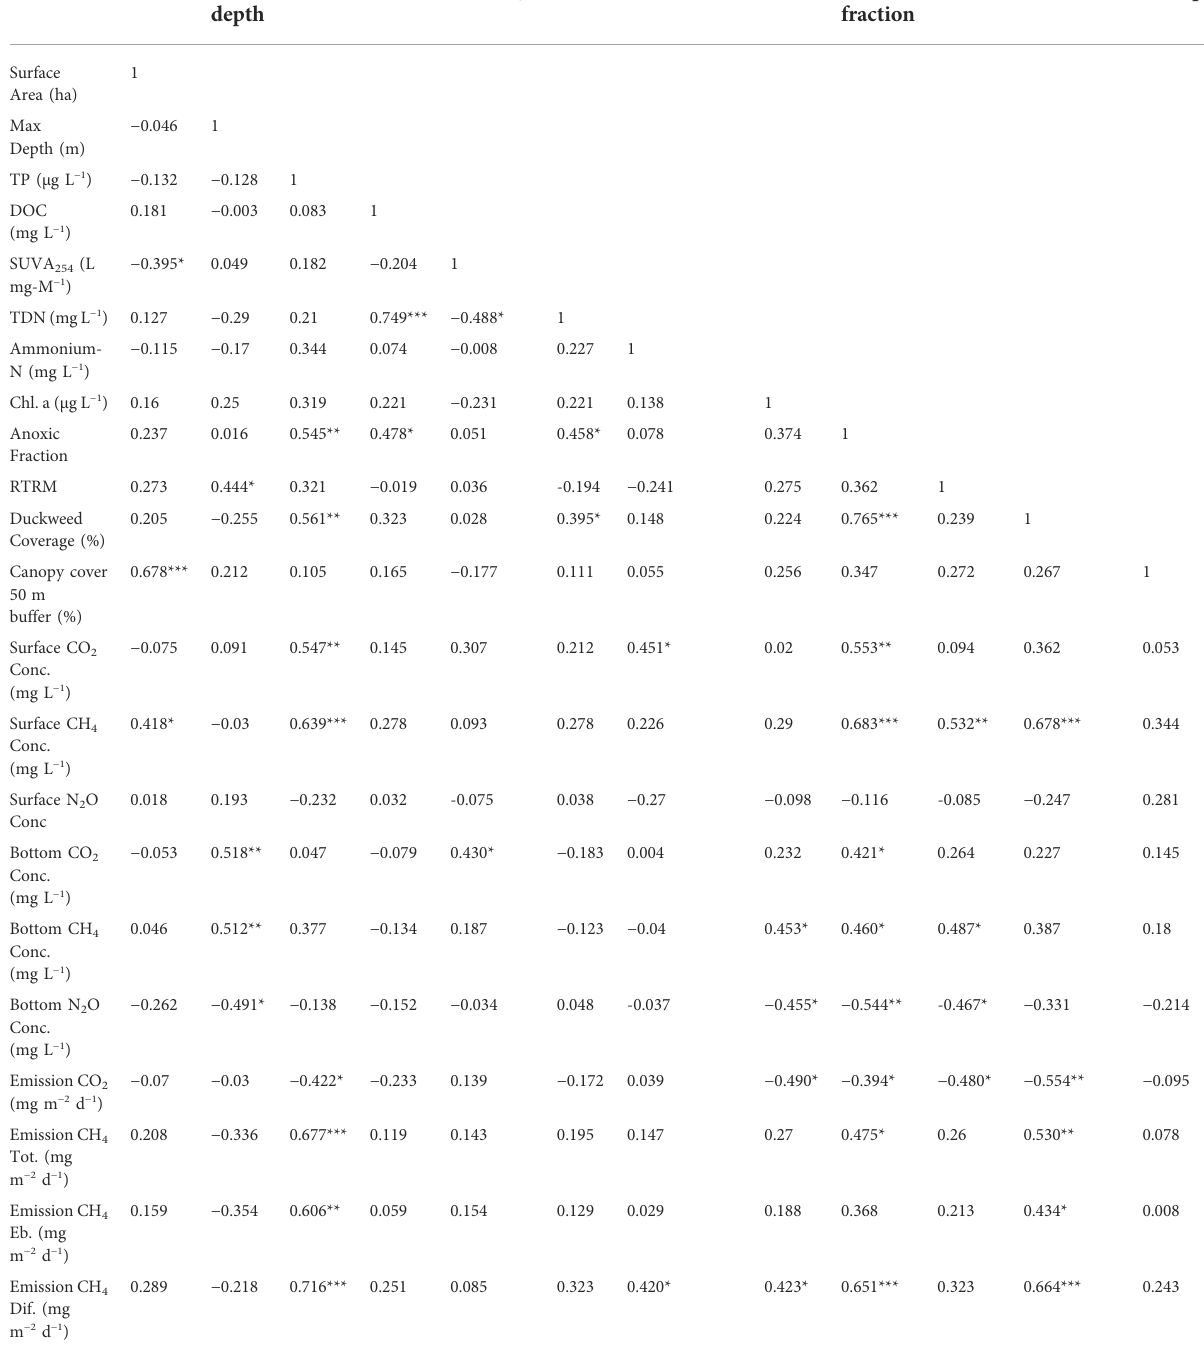
TABLE 4 Pearson correlation coef fi cients between environmental variables and greenhouse gas metrics for all ponds ( n = 26 for all variables). * indicates signi fi cance (* p < 0.05, ** p < 0.01, *** p < 0.001). Area Max TP depth